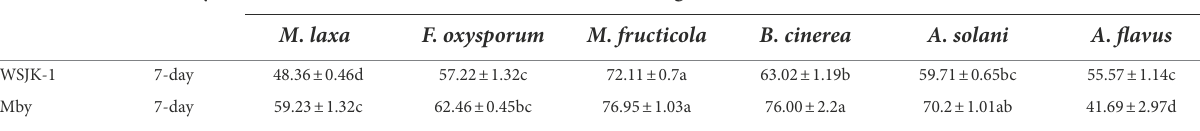
TABLE 2 In vitro antifungal activity of the VOCs produced by WSJK-1 and Mby strains.